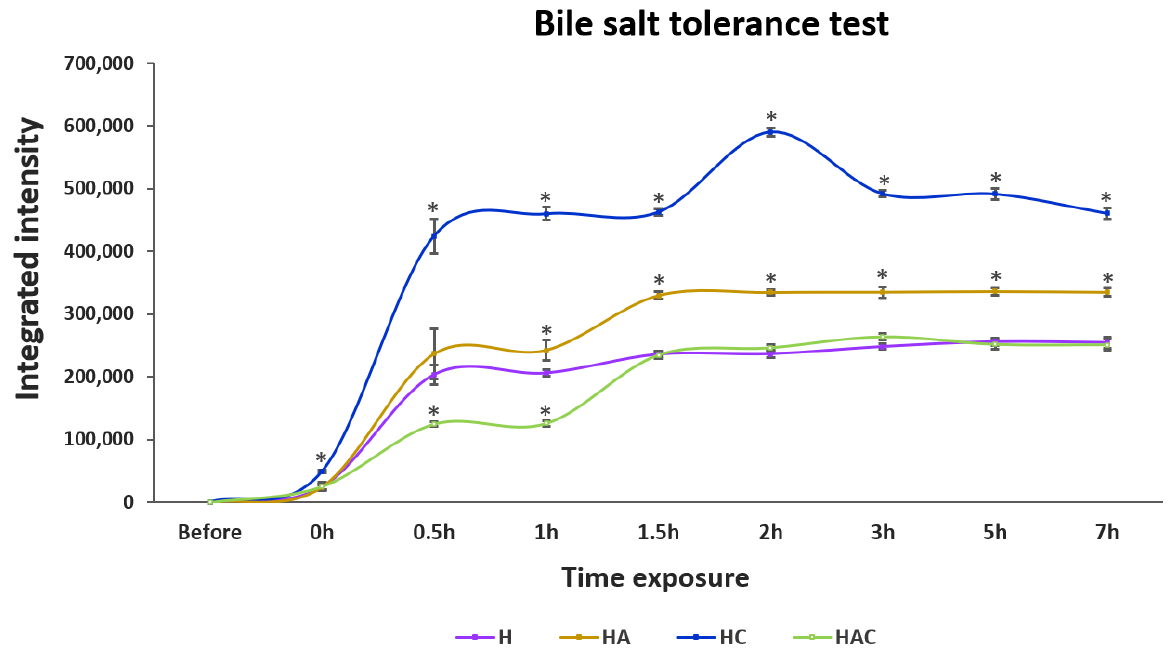
Figure 3. The integrated intensity profile of S. agalactiae protein-lysate-loaded HNTs exposed to 0.3% bile salt solution for 7 h. H, HA, HC and HAC represent the protein-releasing profiles of HNT, HNT-APTES, HNT-Chitosan and HNT-APTES-Chitosan, respectively. Statistical analysis was performed via a paired two-sample t -test: for an analysis of means with p < 0.05. “*” indicates a significant difference between unmodified (H) and other modified HNTs (HA, HC and HAC) at each time point.